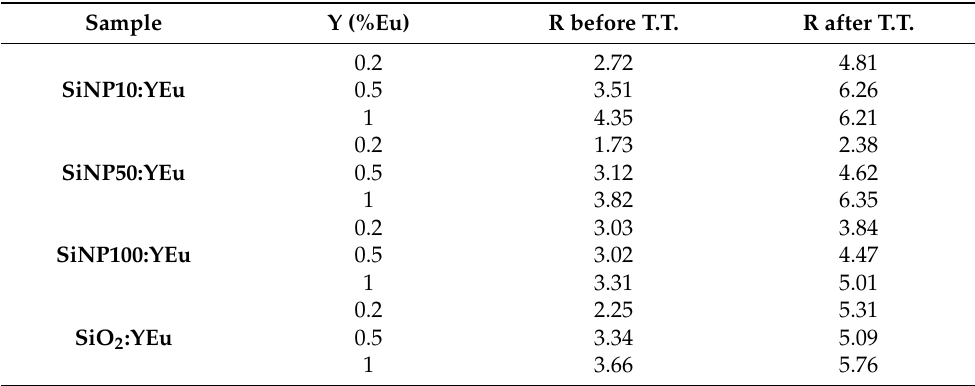
Table 3. Intensity ratio R of Eu-doped silica nanoparticles and bulk before and after thermal treatment (T.T.) at 900 ◦ C. Sample Y (%Eu) R before